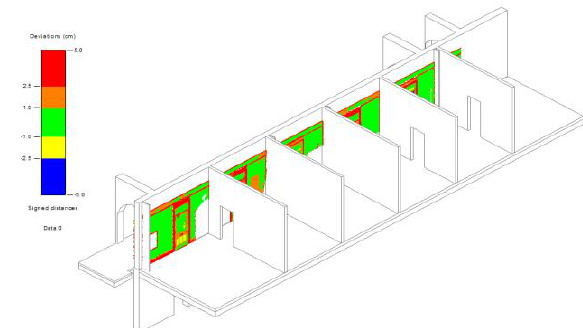
Figure 5: Plug-in for wall